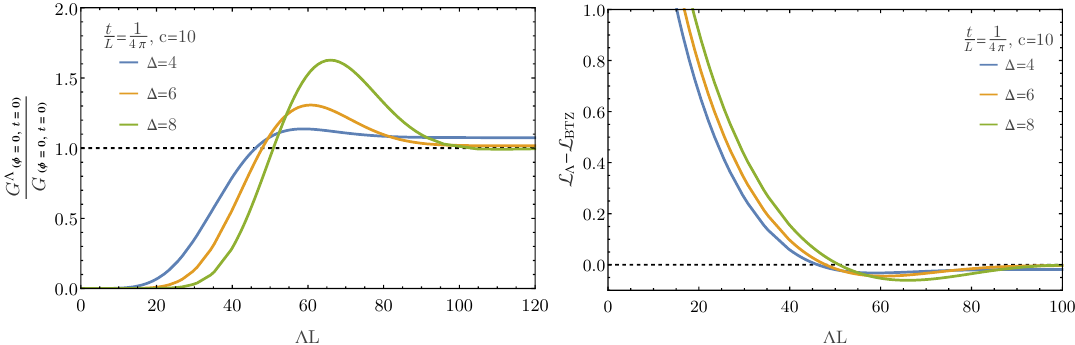
Figure 6 . Normalized Wightman function with (cid:12)nite cuto(cid:11) (left) and length di(cid:11)erence from BTZ (right) as de(cid:12)ned in eq. (4.7) for (cid:12)xed (cid:12)=L = 1 = 2. The central charge is c = 10 and spatial separation is